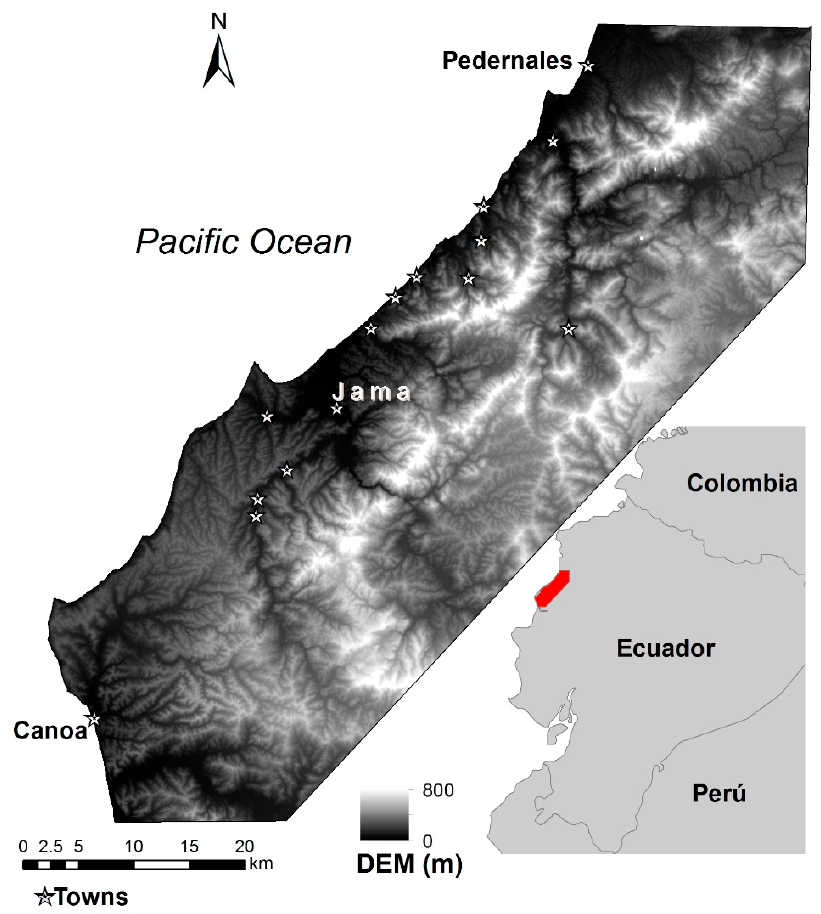
Figure 1. Location of the study area .